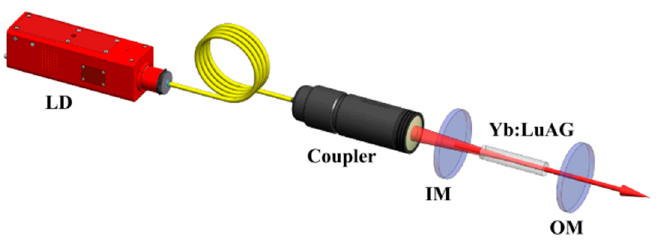
Figure 4. A schematic diagram of the Yb:LuAG single-crystal fiber (SCF) laser setup.